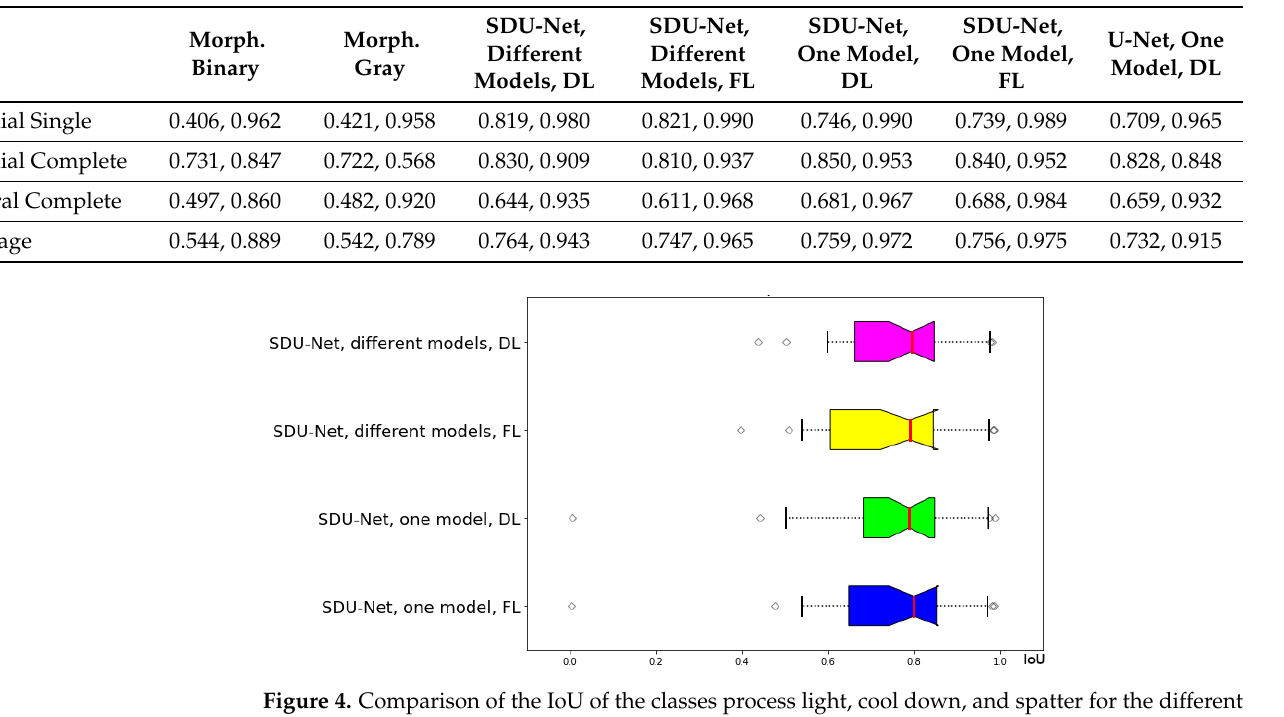
Table 2. Evaluation results of the different approaches. The first value shows the average IoU value of the pixel which was assigned to a specific class, excluding the background class and the second value shows the average IoU value for the entire image.